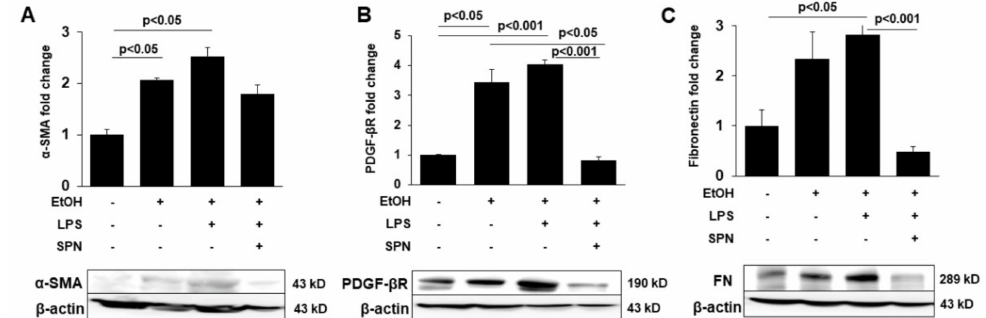
Figure 4. Spermidine prevents ethanol and LPS-induced expression of markers of hepatic stellate cell activation and fibrogenesis. Whole homogenates were prepared from livers of mice treated in the absence (control) or presence of ethanol (EtOH), LPS and/or spermidine (SPN) as indicated and immunoblotted with antibodies specific to α SMA ( A ), PDGF- β R ( B ) or fibronectin (FN) ( C ). Densitometric comparison of the immunoreactive species was performed to determine relative levels of expression. Values were normalized to total β -actin levels and are plotted as fold-increase. Representative immunoblots are shown for each marker. For each experimental condition, four mice were analyzed ( n = 4). The values represent means of triplicate experiments ± SE.